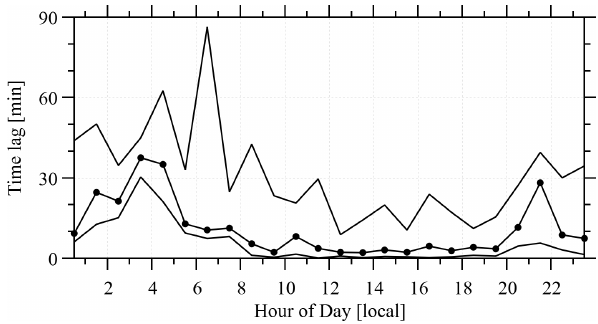
Figure 8. Using the time series of TSI DustTraks the delay between changes in concentration at the canopy top and identical changes near the surface can be determined and is binned here by hour of day. Medians, 10th percentiles, and 90th percentiles are